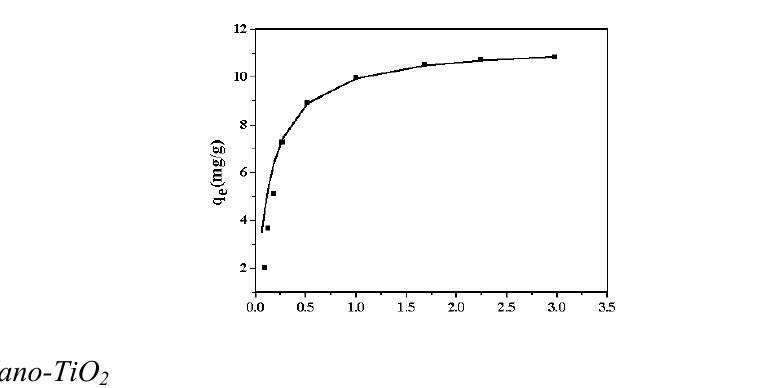
in the culture medium; pH = 7.0; 2